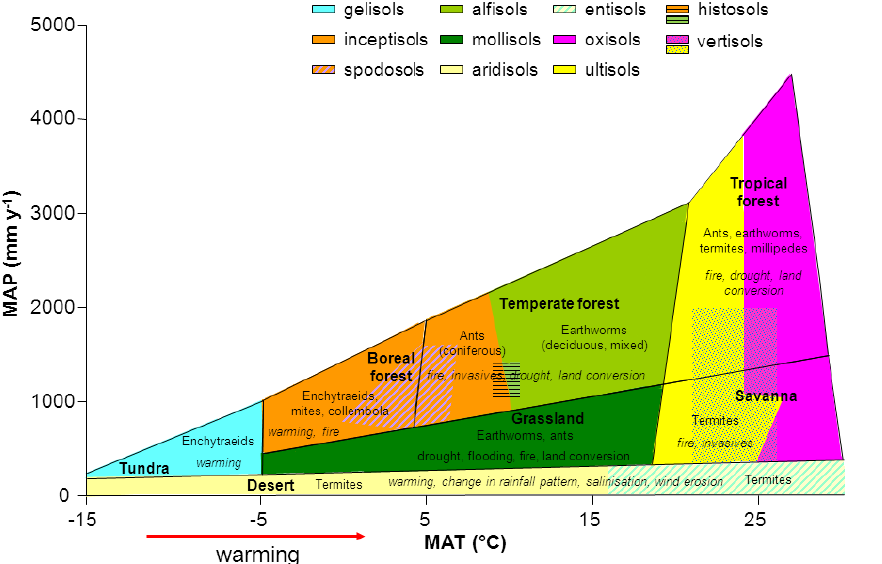
Figure 2. Dominant soil types and characteristic soil forming invertebrates across biomes (major global change threats are shown in italics). MAT: mean annual temperature; MAP: mean annual precipitation. For data and biome sources, see Brussaard et al. (2012). © John Wiley and Sons. Reprint (slightly modified) by kind permission from John Wiley and Sons and Oxford University